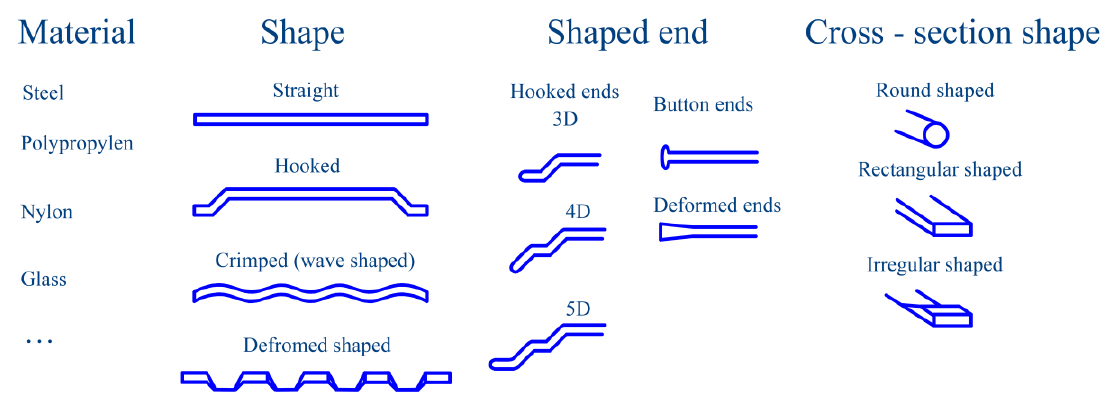
Figure 2. Shapes and types of fibers.